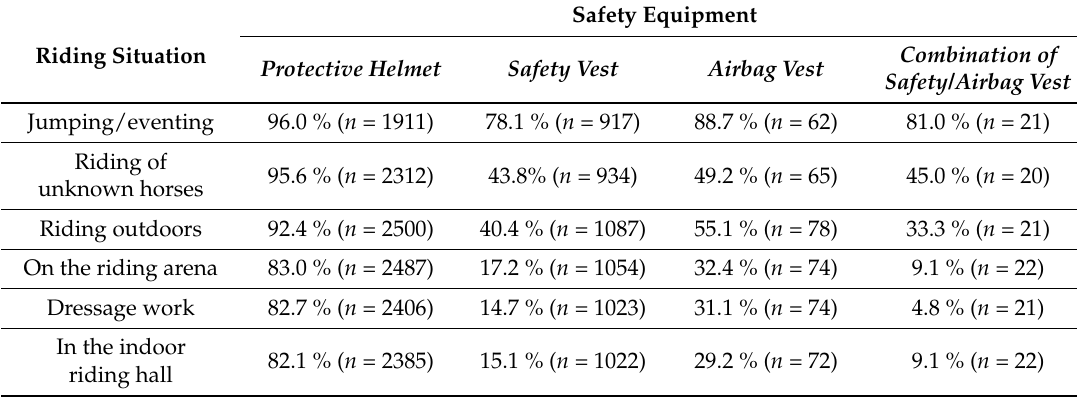
Table 4. Percentage of riders always or often using safety equipment in different riding situations